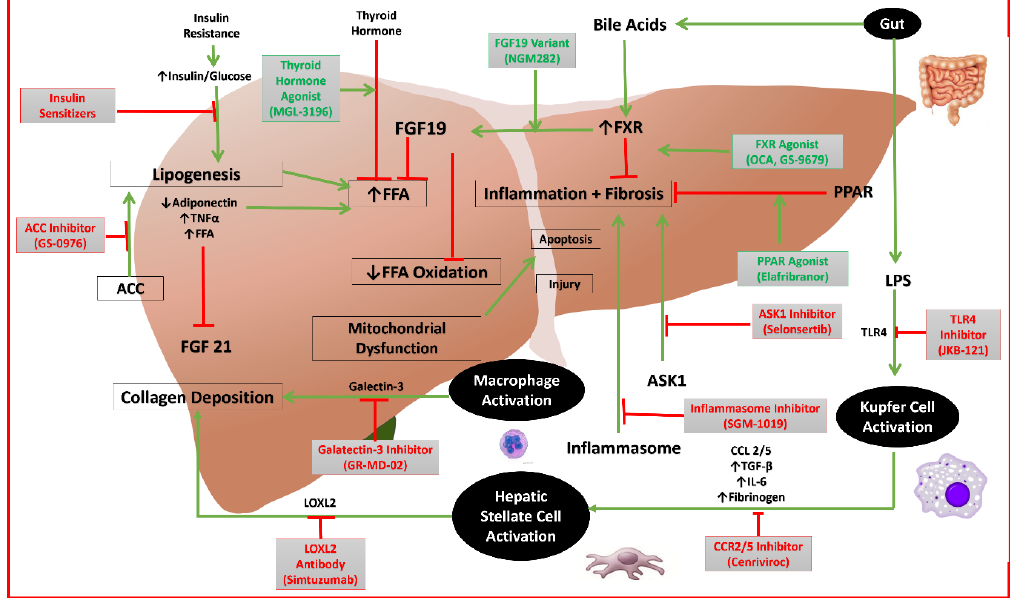
Figure 1. Mechanisms of action of emerging drugs for NAFLD. (FFA: free fatty acid; FGF19: fibroblast growth factor 19; PPAR: peroxisome proliferator-activated receptor alpha; TNF: tumor necrosis factor; TGF: transforming growth factor; IL: interleukin; LPS: lipopolysaccharide; ACC: acetyl-coenzyme A carboxylase; CCL: C-C chemokine ligand; CCR: C-C chemokine receptor; TLR: toll-like receptor; LOXL: lysl oxidase-like; ASK: apoptosis signal-regulating kinase; FXR: farnesoid X receptor).